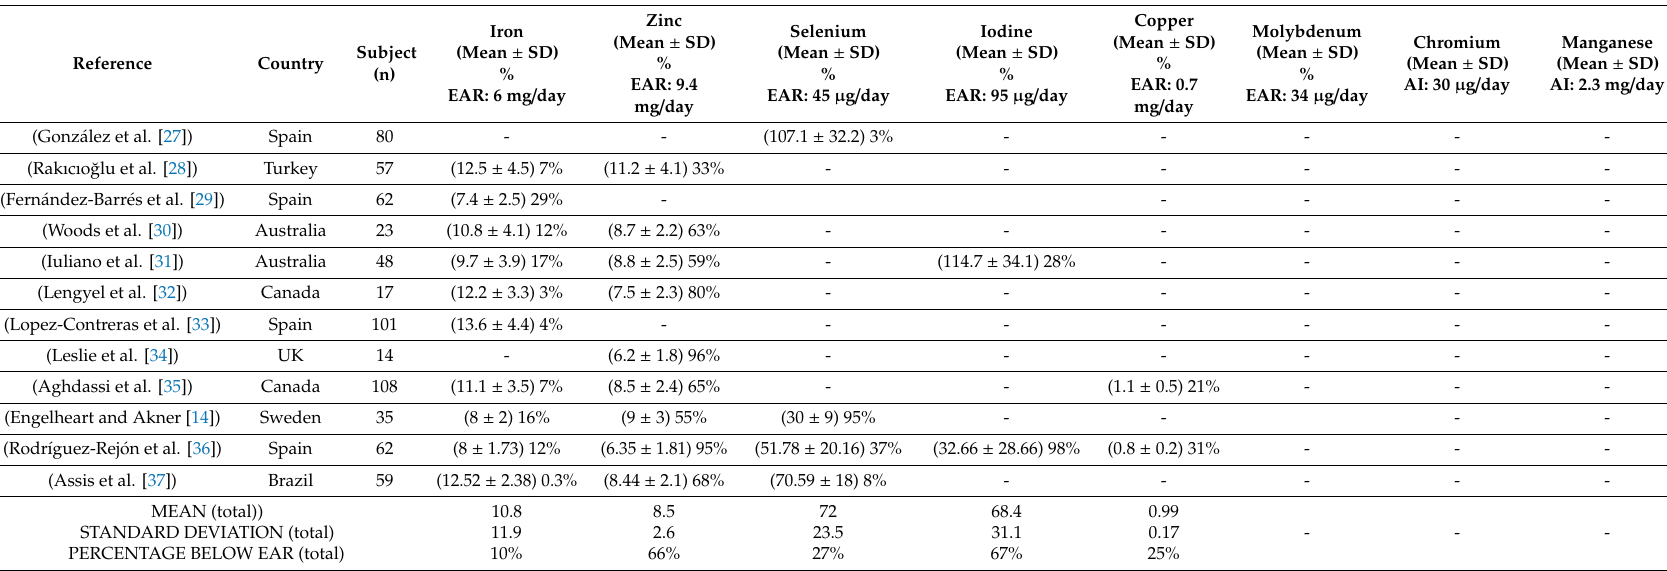
Table 7. Individual study data and percentage of institutionalised older adults at risk for inadequacy for trace minerals in